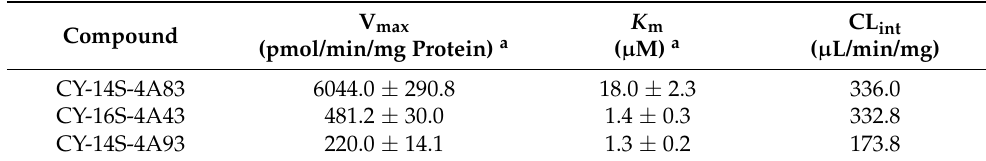
Table 3. Kinetic constants for the disappearance of CY-14S-4A83, CY-16S-4A43, and CY-16S-4A93 in rat hepatic microsomes.